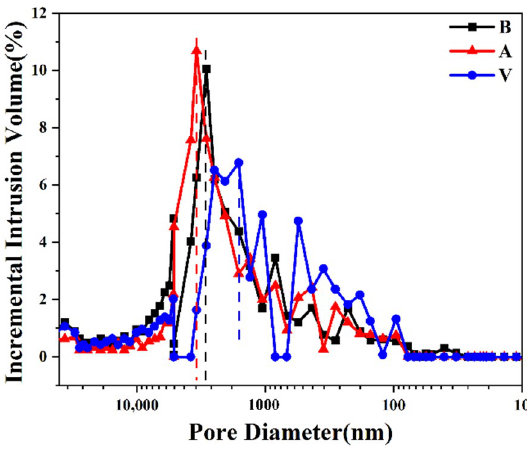
Figure 11. Sandstone samples pore size